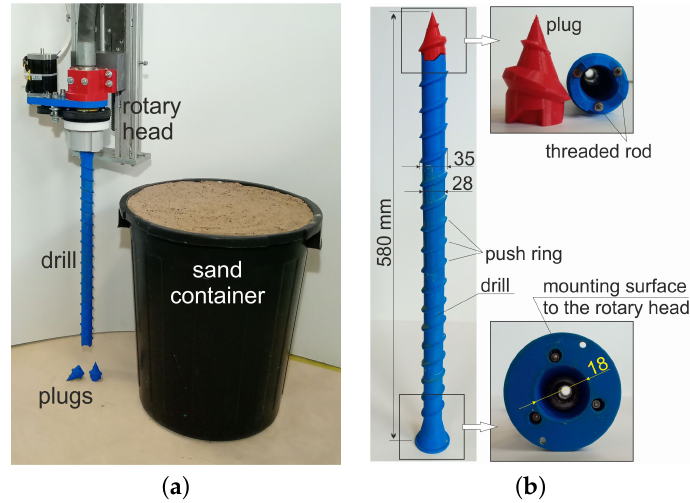
Figure 5. ( a ) Station for making foundation piles, ( b ) drill structure.